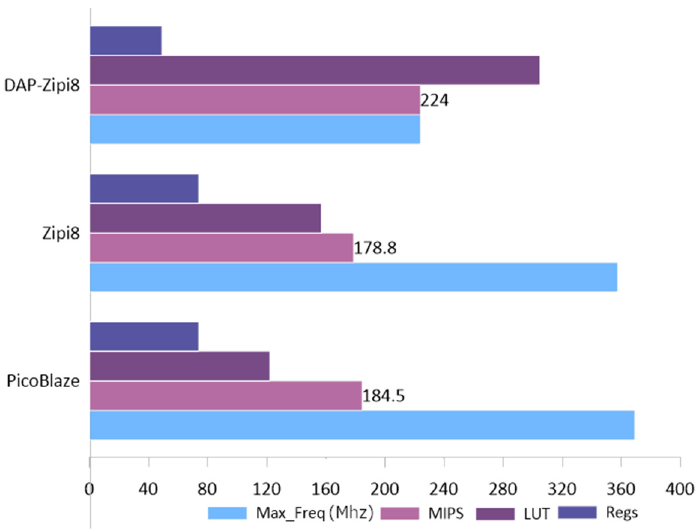
Figure 13. PicoBlaze vs. Zipi8 vs. DAP-Zipi8 performance and resource utilization comparison.